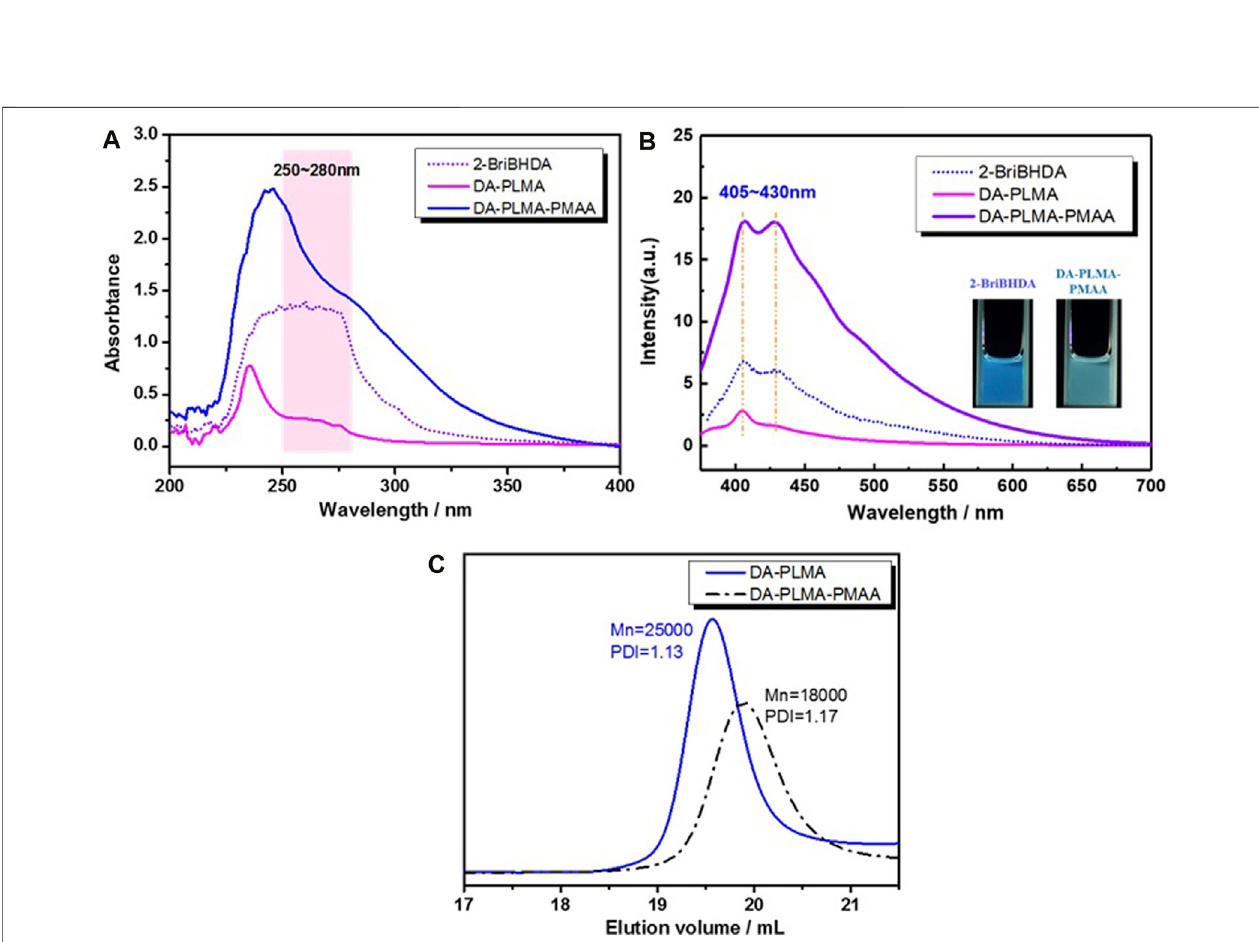
FIGURE5 |(A) UV absorption curvesand (B) fl uorescence spectra (inset: digital photograph taken under 365 nm) ofthe rosin-based initiator, DA-PLMA,and DA- PLMA-PMAA in THF; (C) GPC traces of DA-PLMA and DA-PLMA-PMAA.